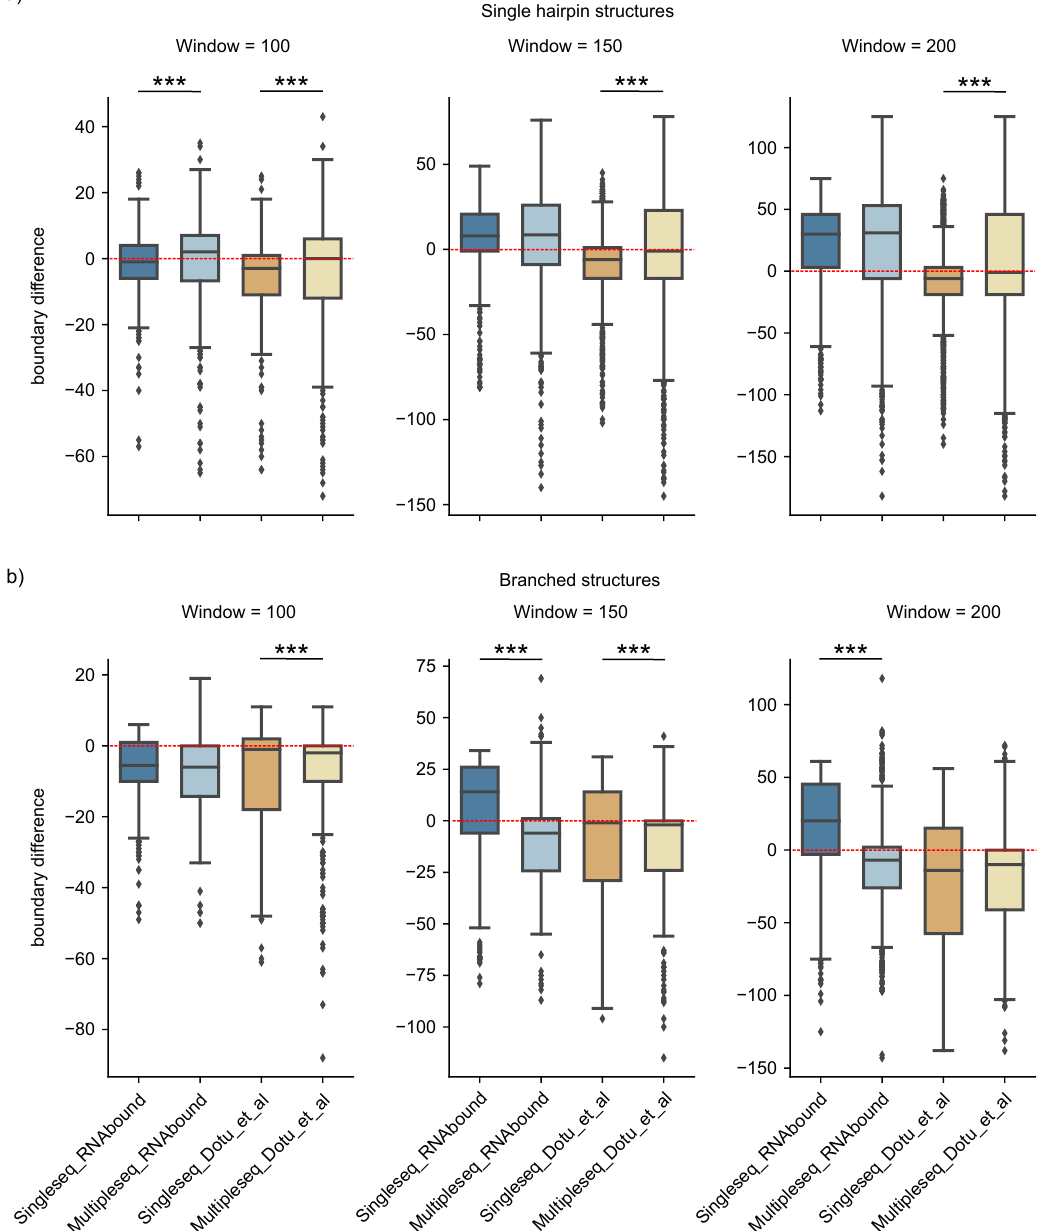
Figure A1. Comparison of RNAbound and Dotu et al. boundary predictions on single sequence versus multiple sequence alignment for all single hairpin structures ( a ) and branched structures ( b ). For simplicity, here we combined the results of left and right boundary differences under each category represented on the x-axis. The distributions that showed significant difference based on the two-sided Wilcoxon rank-sum test are indicated with asterisk symbol (*** p < 0.001, ** p < 0.01, and * p <